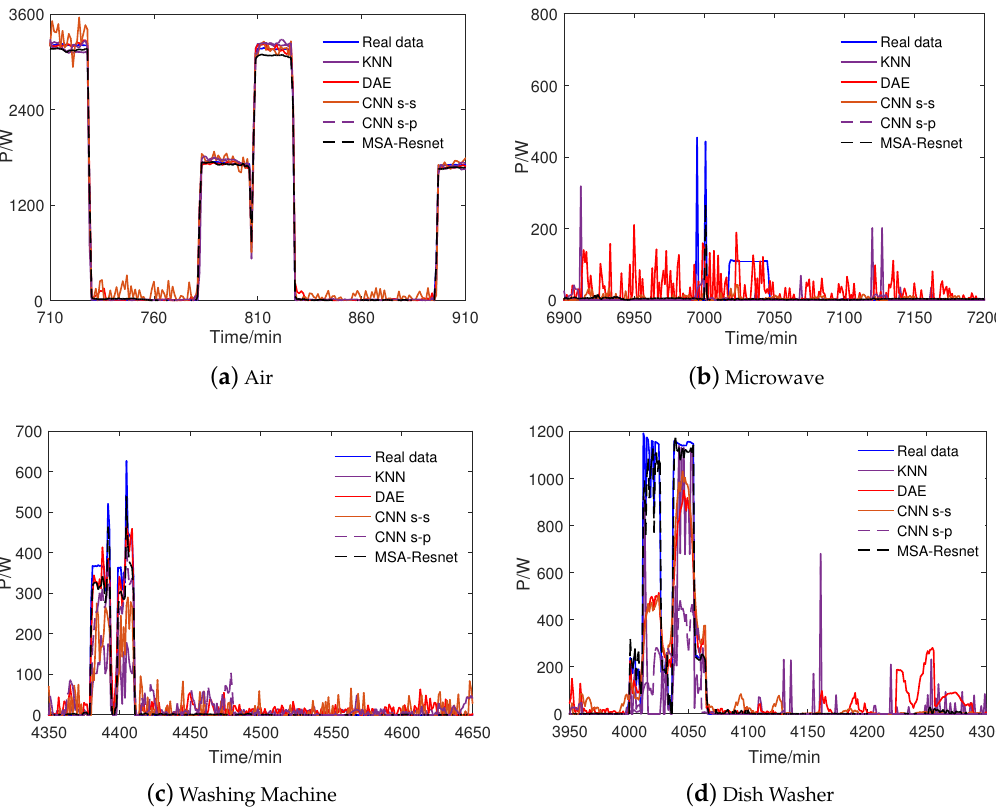
Figure 8. Load disaggregation comparison for Household 25 of the WikiEnergy